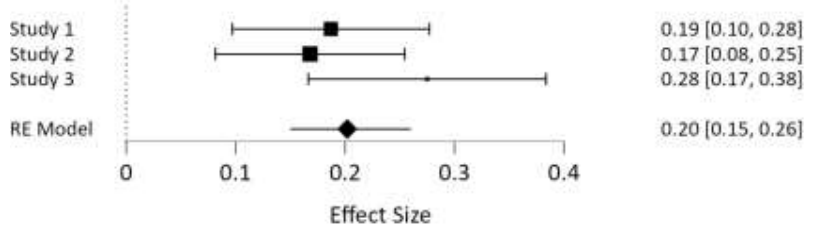
Figure 11. Forest plot of meta-analysis of Motivation for knowledge and